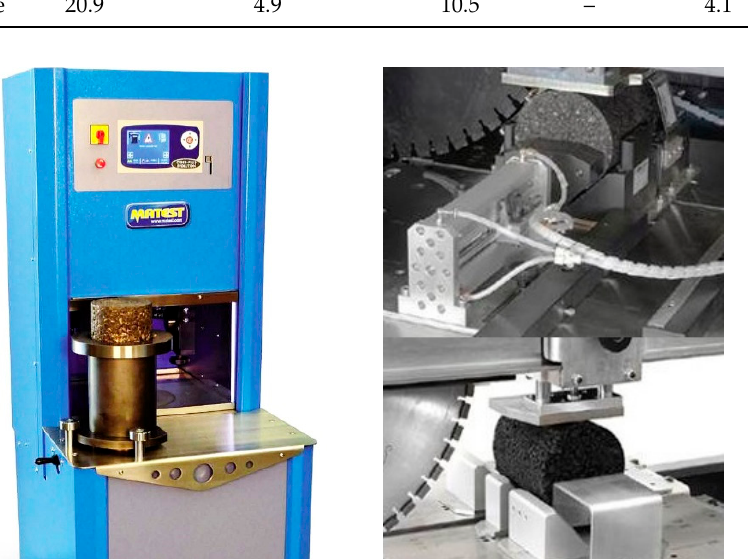
Figure 3. Gyratory compactor device and test specimens. Table 3. The Marshall test results.